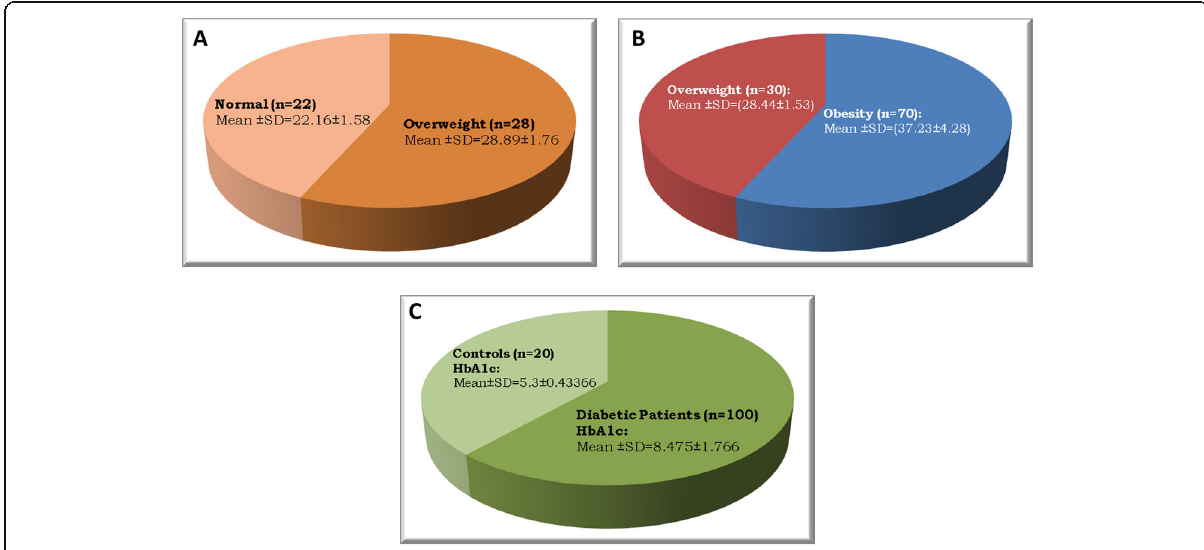
Fig. 1 Schematic representation of the distribution of controls and diabetic patients with BMI and HbA1. A Body mass index in healthy controls divided to normal ( n = 22, 44%) and overweight ( n = 28, 56%) and B body mass index in patients divided to overweight ( n = 30, 30%) and obese ( n = 70, 70%) individuals. C Contribution of glycosylated Hb (HbA1c) in controls ( n = 50) and diabetic patients ( n =